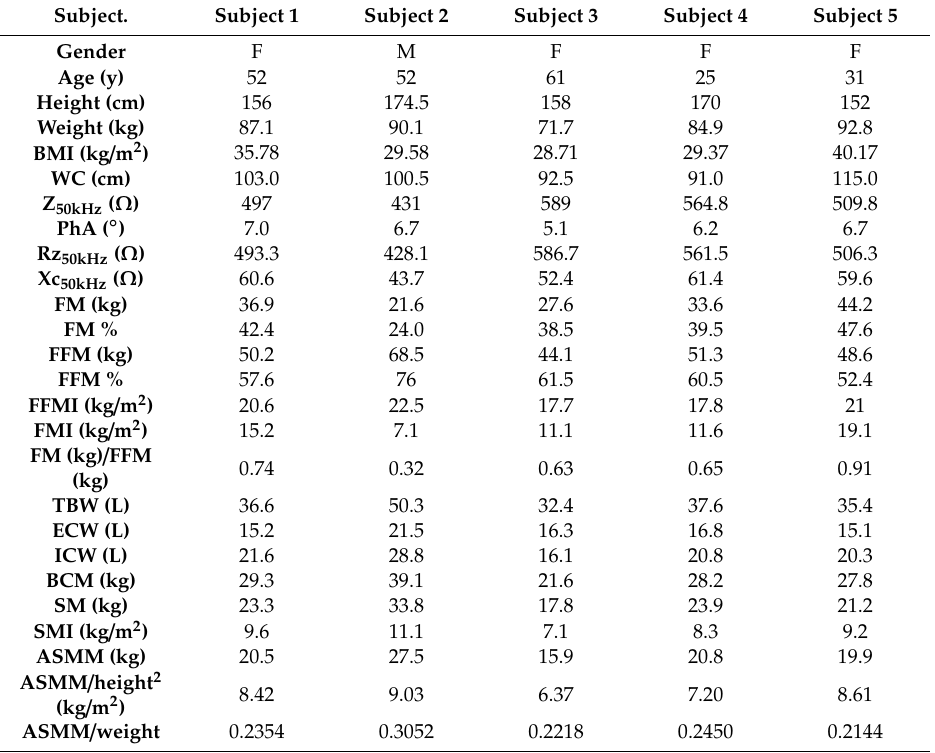
Table 1. Description of recruited